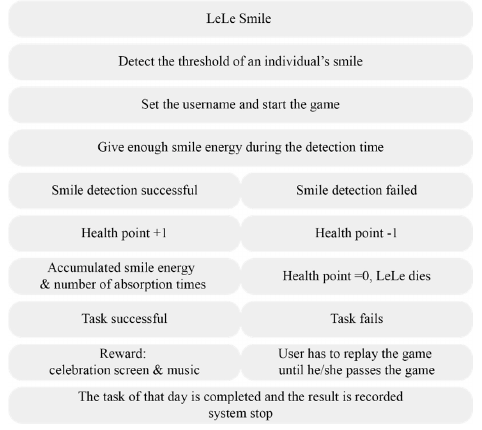
Figure 8. Flow chart of experiment process.